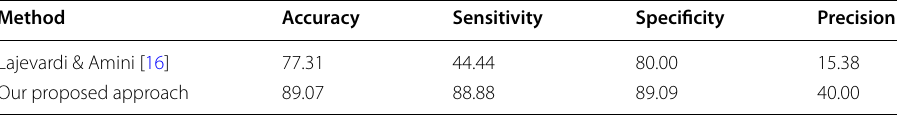
Table 14 Results of comparing two APT detection approaches Method Accuracy